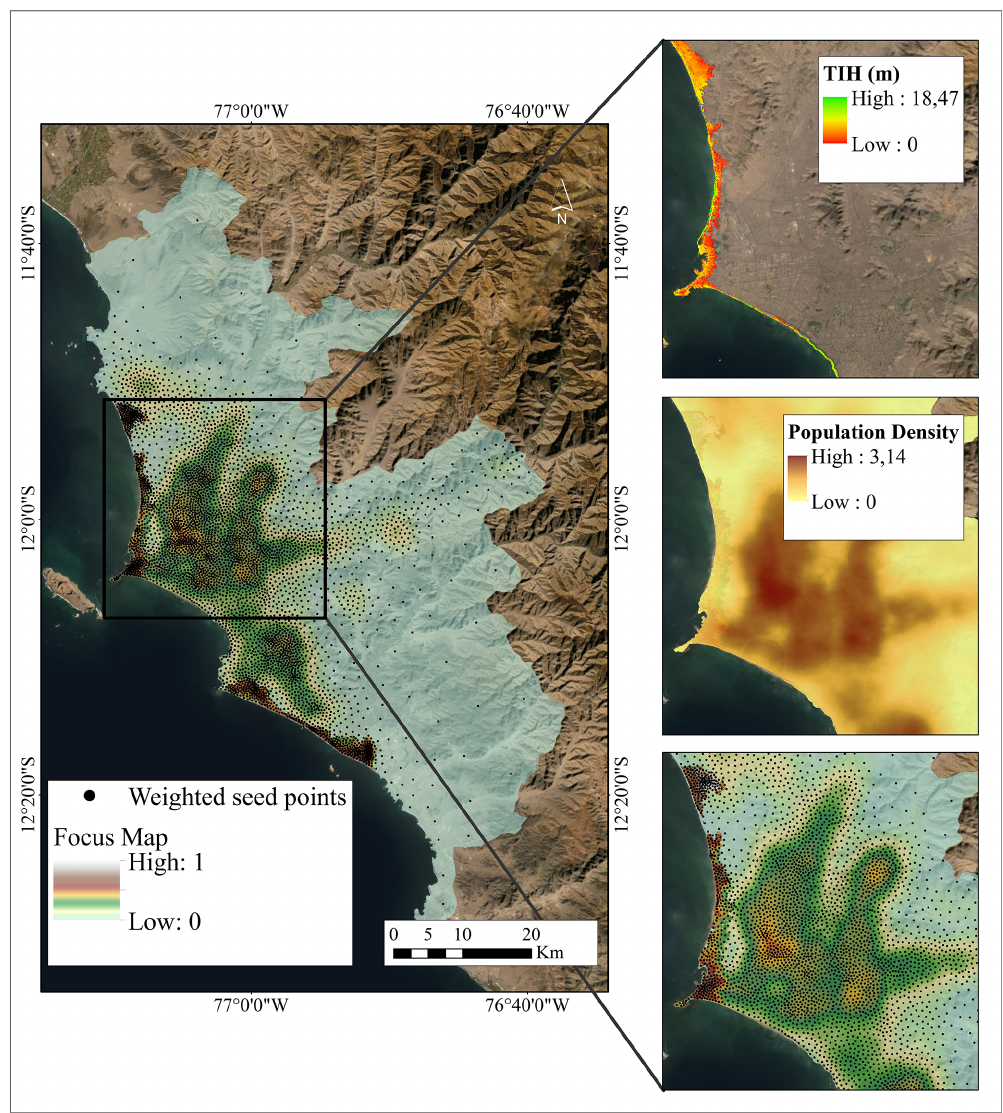
Figure 5. Example of the construction of focus map and CVT models for Lima. (a) A total of 5000 weighted seeding points sample a focus map through a Poisson point process. The normalised focus map is constructed from a log-linear pooling algorithm of the combined layers (population density (PD) and tsunami inundation height (TI) with a selection of 30% and 70% weights respectively). Map data: © Google Earth